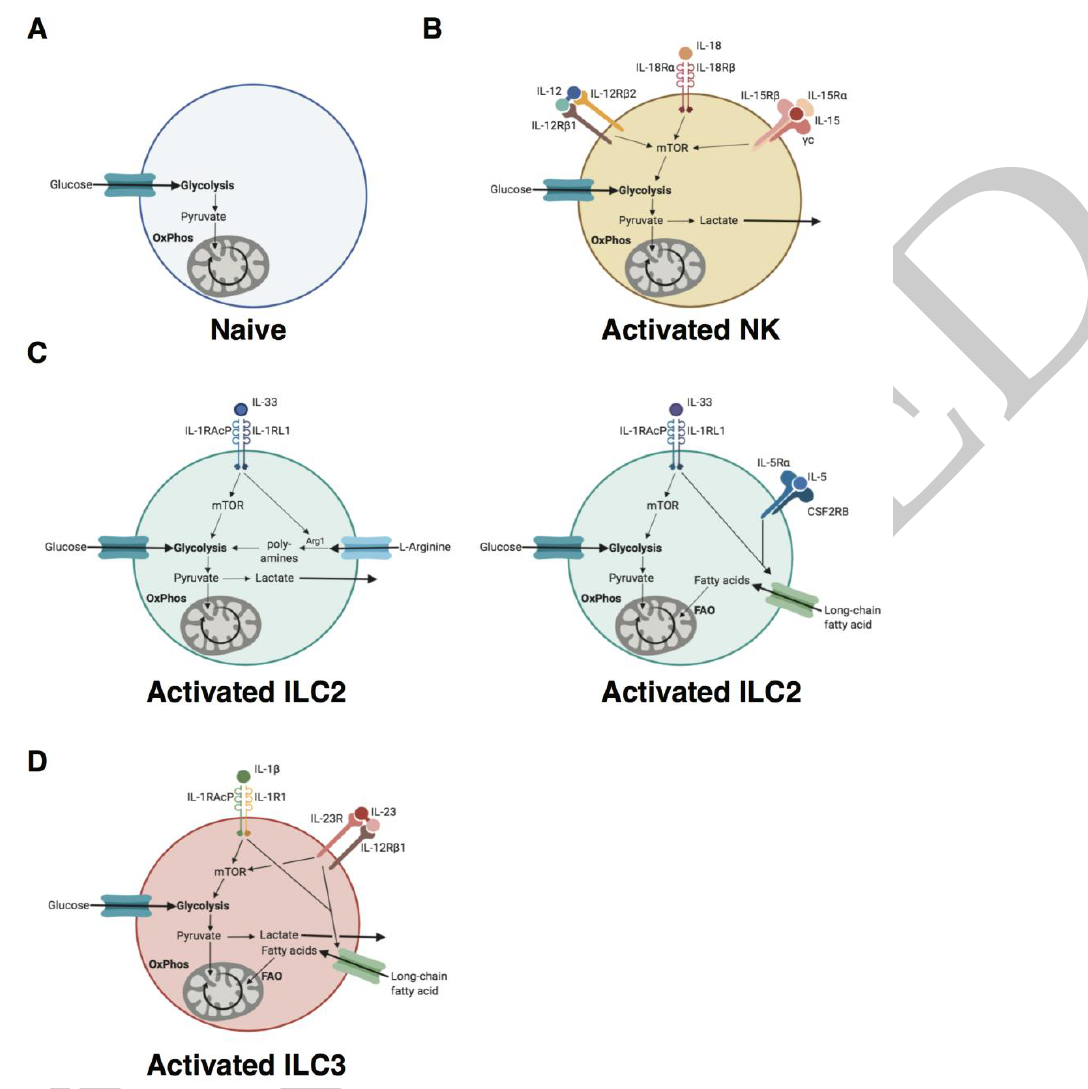
Figure 1. Metabolic pathways utilized by innate lymphoid cells (ILCs) during homeostasis and activation. ( A ) Naive ILCs are generally thought to be quiescent and largely use metabolic pathways that efficiently metabolize glucose through glycolysis-linked mitochondrial oxidative phosphorylation (OxPhos) to generate energy in the form of adenosine triphosphate (ATP). However, during inflammation, ILCs respond to increased levels of proinflammatory cytokines that cause their activation and concomitant changes in cellular metabolism. ( B ) Activated natural killer (NK) cells respond to heighten levels of the cytokines IL-12, IL-18, and IL-15 through activation of mammalian target of rapamycin (mTOR) signaling, which is associated with an increased rate of glycolysis to meet higher biosynthetic demand by metabolizing glucose into lactate in a process called aerobic glycolysis. Aerobic glycolysis is needed to provide the cell with essential precursors for amino acids, lipids, and nucleotides to fuel effector function and proliferation. ( C ) Following IL-33 stimulation, activated ILC2s can also increase aerobic glycolysis, which is dependent on arginase-1 ( Arg1 ) activity to metabolize extracellular L -arginine into ornithine-derived polyamines to fuel increased glycolysis (left panel). Alternatively, ILC2s take up extracellular long-chain fatty acids through an undefined transporter and utilize mitochondrial fatty acid oxidation (FAO) to fuel proliferation and effector function without the need of glucose uptake (right panel) ( D ) In response to IL-1 β and IL-23, ILC3s increase both glucose and fatty acid metabolism and display increased mitochondrial oxygen